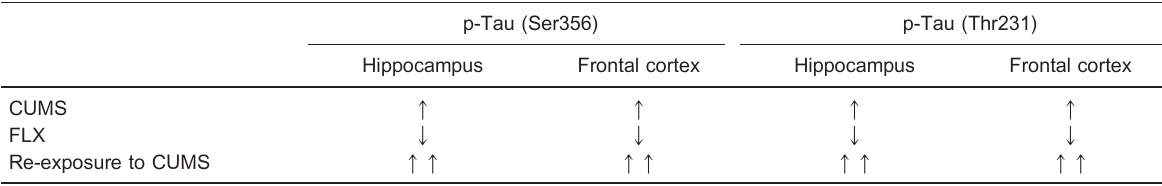
Table 1. Main results of the present